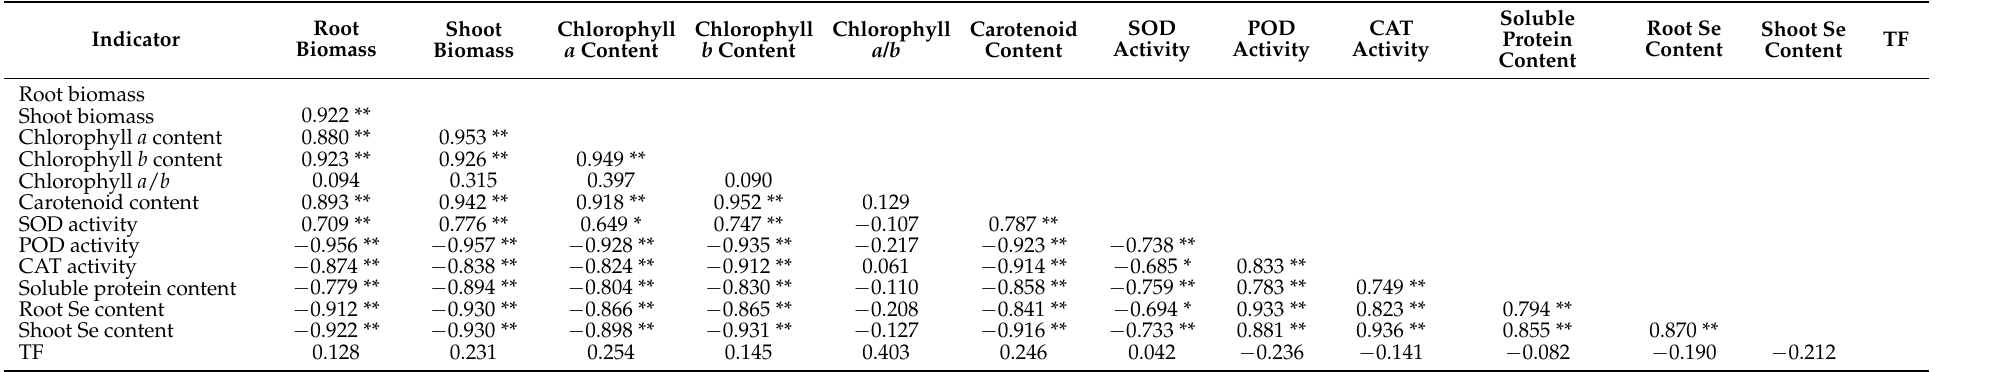
Table 3. Correlations among the different indicators of C. betacea .